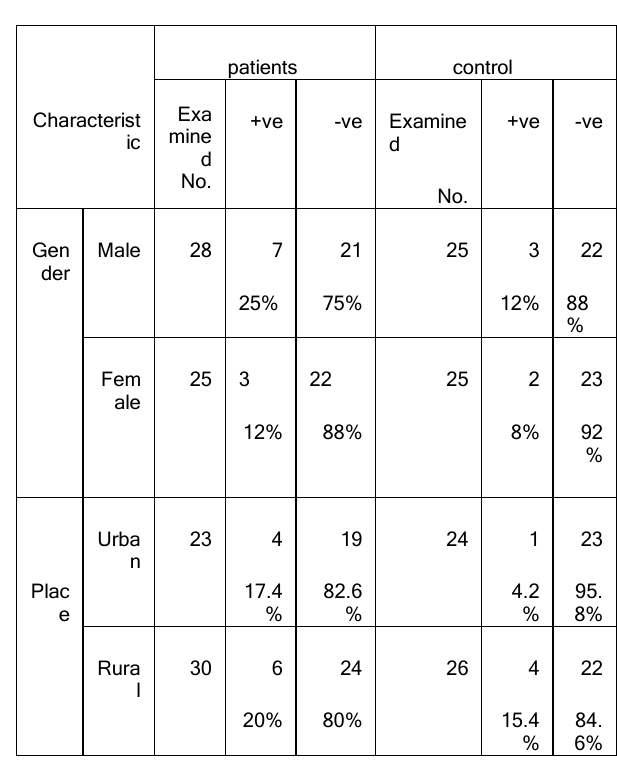
Fig.1: Difference between infection rate with Blastocystis spp. in leukemic children and control Table 1: The rate of infection with Blastocystis